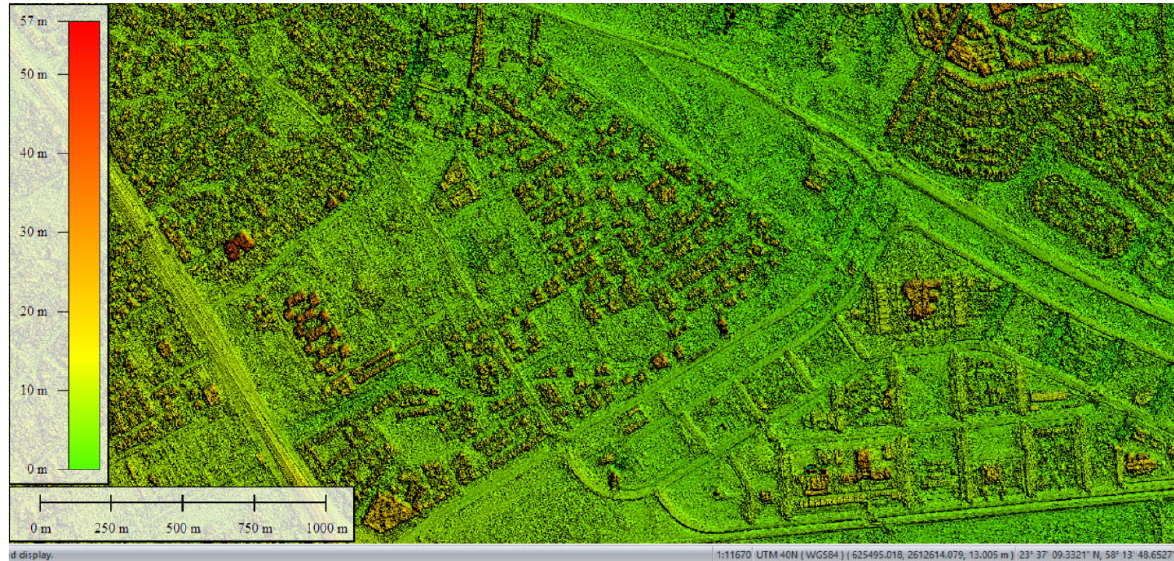
Figure 5. Part of the DEM of the study area performed using the SGG method and visualized in Global Mapper software.